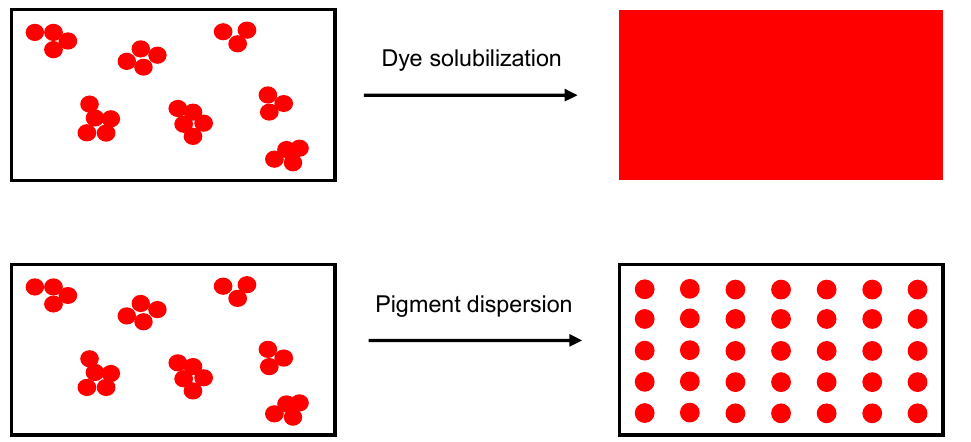
Figure 1. Schematic representation of dye solubilization and pigment dispersion.